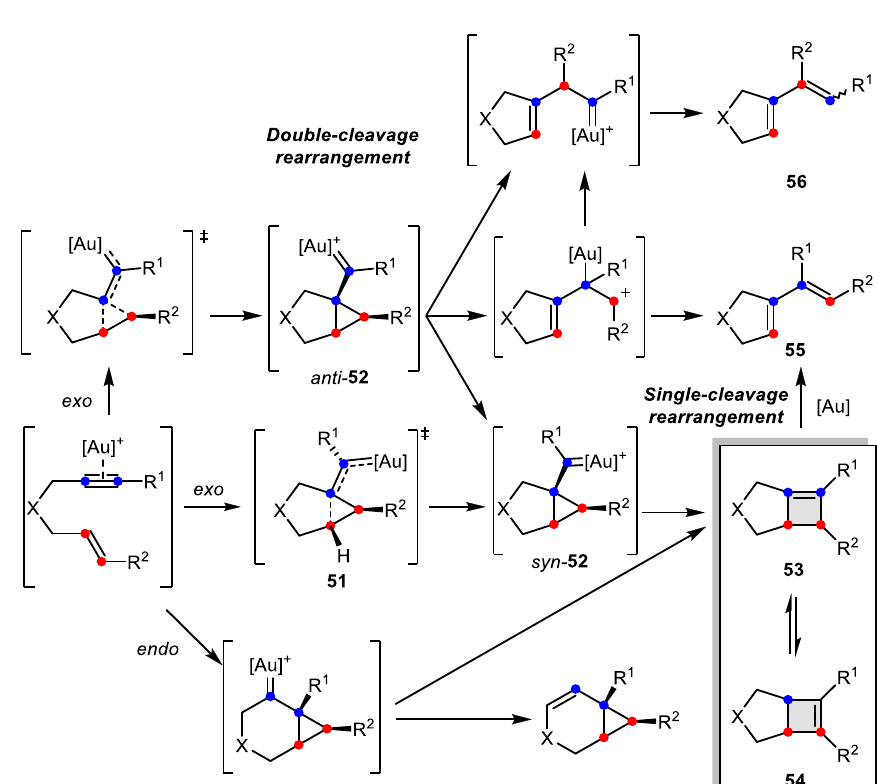
Scheme 17. General pathways for gold-catalyzed 1,6-enyne cycloisomerizations.